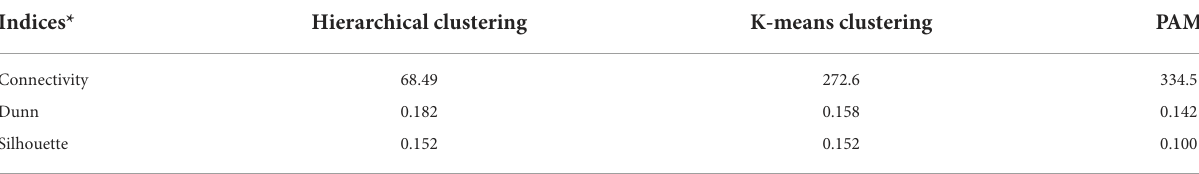
TABLE 3 Connectivity, dunn, and silhouette indices of three commonly used clustering methods in three clusters.